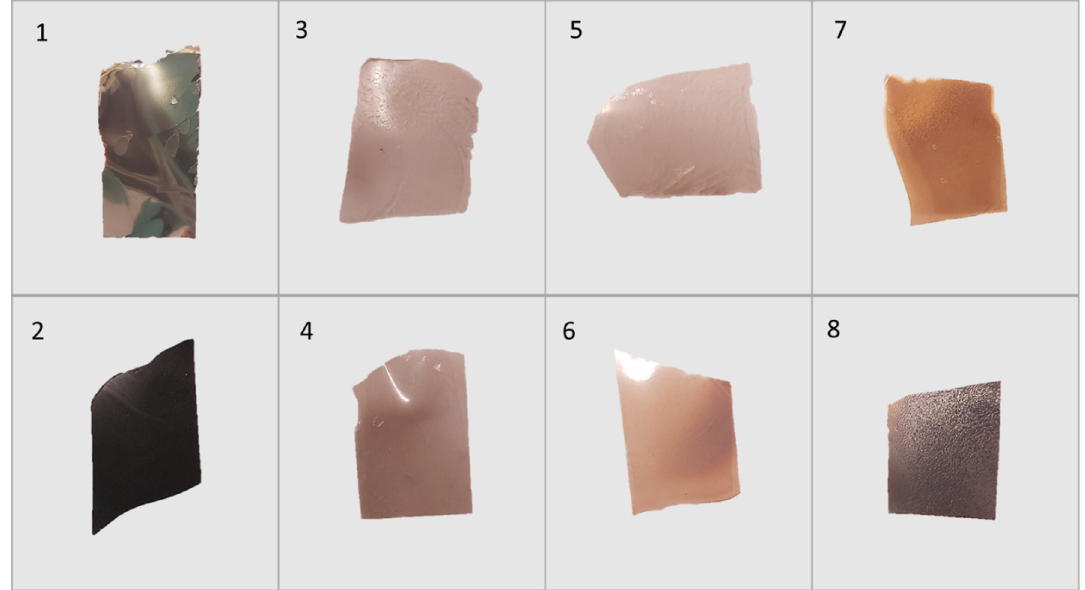
Figure 1. Appearance of CNC cast films including various silver salts. ( 1 ) SDF with CNC, ( 2 ) SDF with CNC and glycerol, ( 3 ) AgNO 3 with CNC, ( 4 ) AgNO 3 with CNC and glycerol, ( 5 ) Ag 2 SO 4 with CNC, ( 6 ) Ag 2 SO 4 with CNC and glycerol, ( 7 ) Ag Acetate with CNC, and ( 8 ) Ag Acetate with CNC and glycerol.